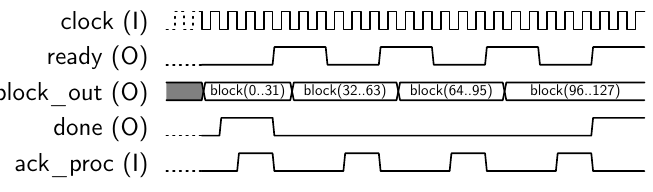
Figure 7. Sequence for block